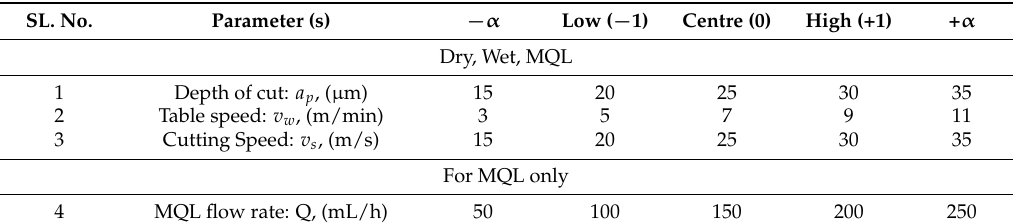
Table 2. Process parameters and their levels for Dry, Wet, and MQL grinding.